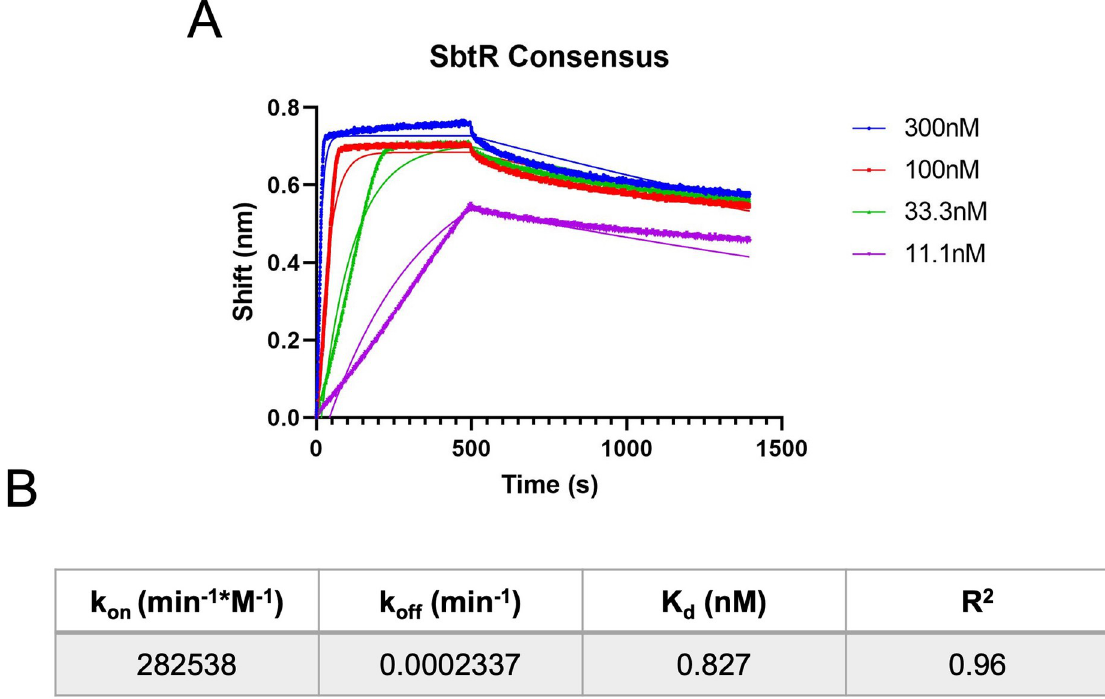
Fig 1. Association and dissociation of SbtR to its consensus DNA-binding sequence. ( A ) Various concentrations of SbtR were subject to BLI analysis. BLI was performed at 30˚C in BLI-100 buffer (20 mM Tris-Cl [pH 7.5], 100 mM NaCl, 1 mM EDTA, and 0.05% Tween-20). Prior to the association step, streptavidin-coated biosensors were conjugated to biotinylated DNA probes containing a previously identified consensus DNA-binding motif for SbtR. In the graph shown, association occurred during the first 500 seconds, then samples were transferred to a buffer-containing well to measure dissociation. Solid lines depict lines of best fit from GraphPad Prism software. Dots represent individual BLI data points, that were taken every 0.2 seconds. ( B ) Kinetic data derived from the experiment shown in (A) are presented.